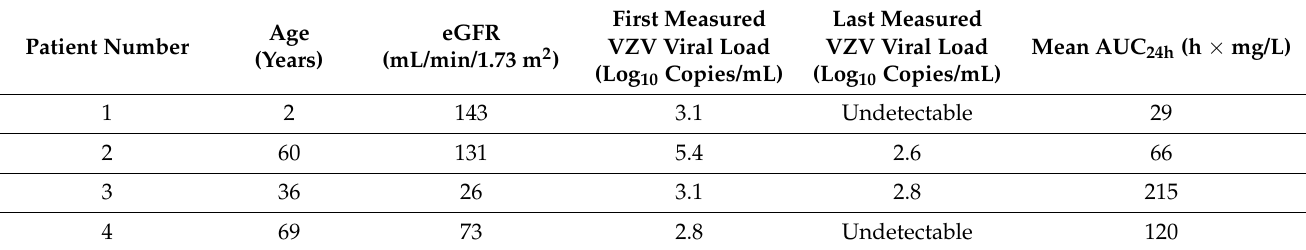
Table 1. Patient characteristics for pharmacokinetic/pharmacodynamic modelling ( N = 4). Mean AUC 24 h is calculated between first and last viral load measurement.